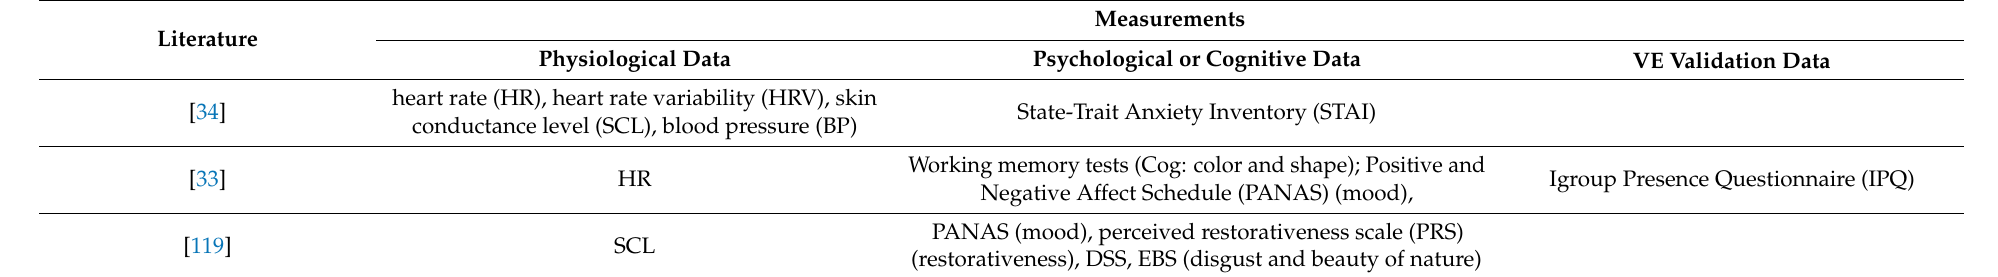
Table A2. Classification of the reviewed studies employing virtual natural environment (factor 4—data collection and